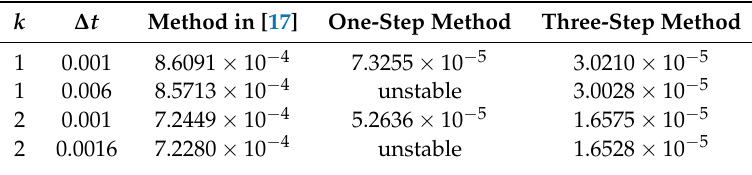
Table 3. The L ∞ error of Example 2 in M = 8.